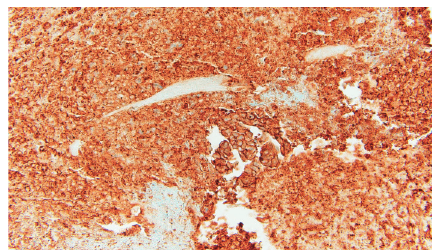
Figure 5: Malignant cells are positive for MOC-31 stain.